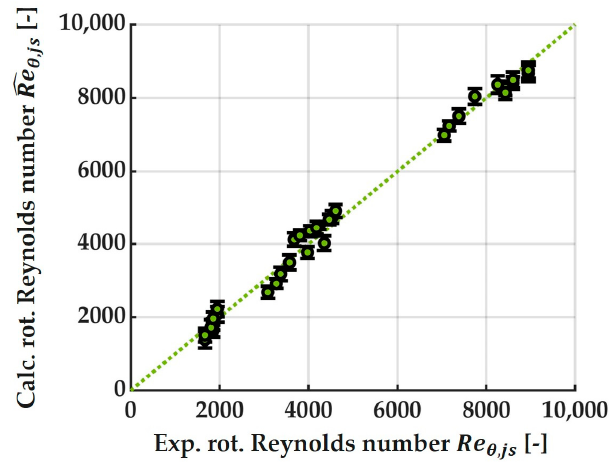
Figure 6. Parity plot displaying the goodness of fit of the regression of the just‑suspended rotational Reynolds number. The error bars indicate the 95% confidence intervals of the regressed data.